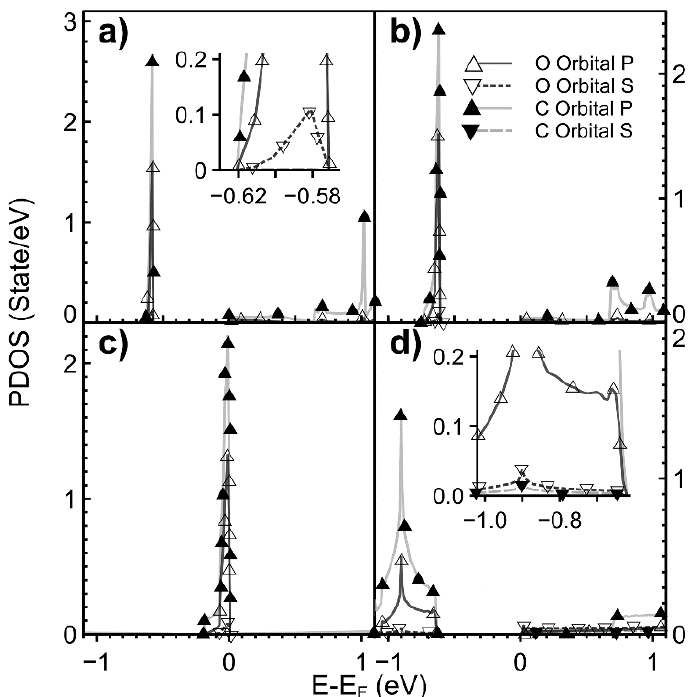
Figure 5. We show the PDOS for different vacancy densities values when the dopant is oxygen. ( a ) 2.00%; ( b ) 3.12%; ( c ) 5.55%; ( d ) 12.5%. For carbon: orbital s:q ; and for orbital p : ▲ . For oxygen: orbital s : ; and orbital p : .